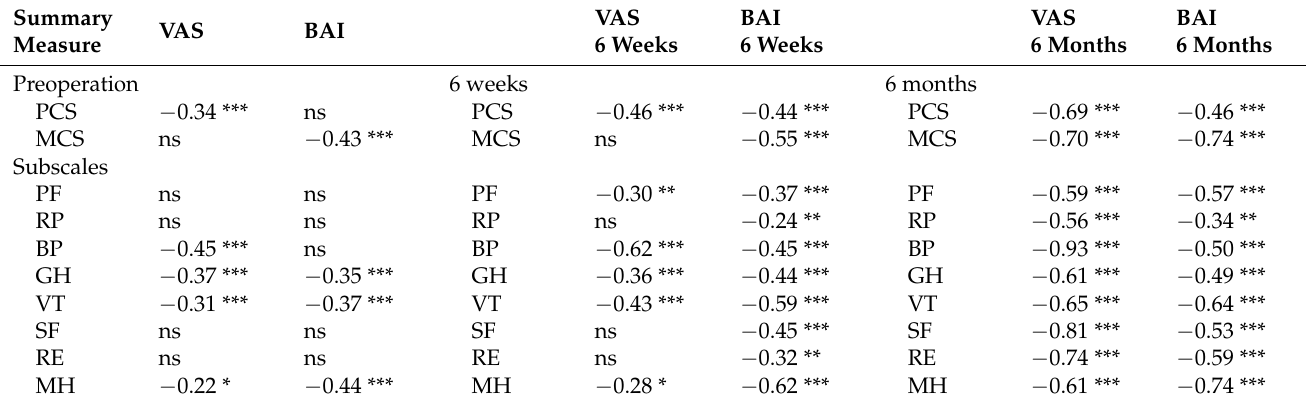
Table 4. The association of VAS and BAI with summary measures and subscales of the